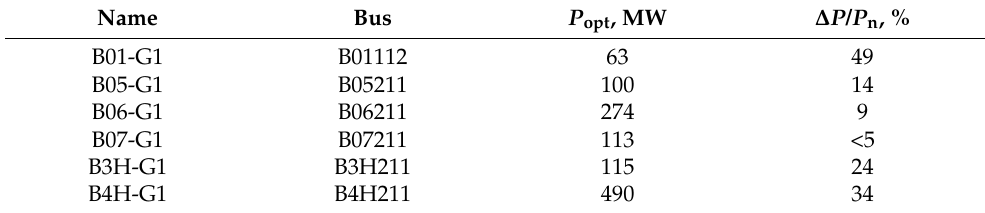
Figure 10. The process of determining the maximum SPA for case 5; ( a ) changing the generation distribution to determine the maximum (global) SPA; ( b ) a graph of changes in the value of the objective function (maximum SPA); ( c ) changing the generation distribution to determine a maximum safe SPA; ( d ) graph of changes in the value of the objective function with the penalty function (maximum safe SPA). Table 7. List of sources with optimal capacity and expected values of power surges calculated for each generator.